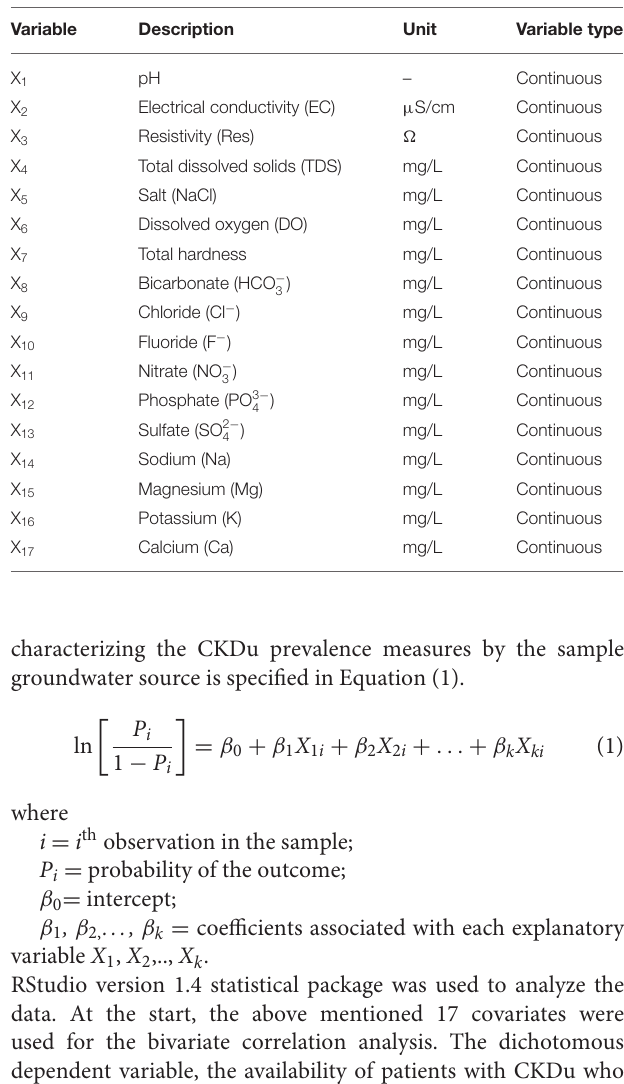
TABLE 1 | Description of explanatory